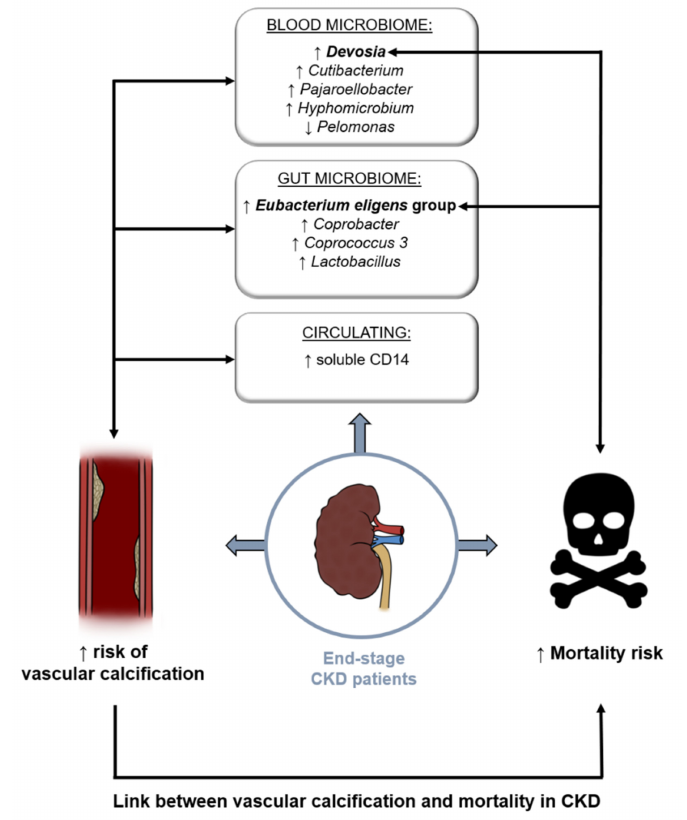
Figure 5. Our results suggest that specific taxa in the gut microbiome ( Coprobacter , Coprococcus 3 , Lac- tobacillus , and Eubacterium eligens group) and in the blood microbiome ( Cutibacterium , Pajaroellobacter , Devosia , Hyphomicrobium , and Pelomonas ) are different between CKD-PD patients with and without VC. sCD14 (a nonspecific marker of monocyte activation) correlated with vascular calcification (VC) severity in CKD-PD patients. An association between VC and all-cause mortality risk in CKD-PD patients was observed and patients with higher mortality risk corroborate the changes of Eubacterium eligen s in the gut and Devosia genus in the